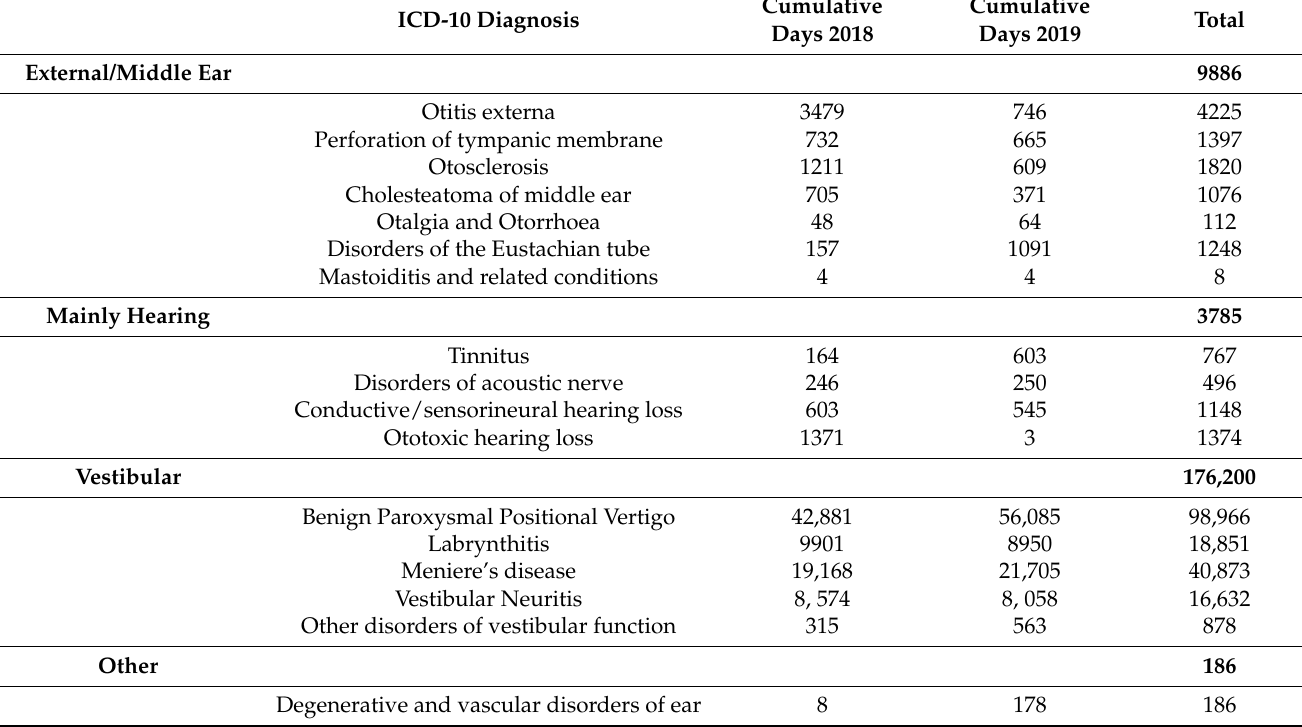
Table 2. Cumulative days of sick leave related to ear diagnoses during years 2018 and 2019, according to Chapter VIII of the International Classification of Diseases, 10th Revision